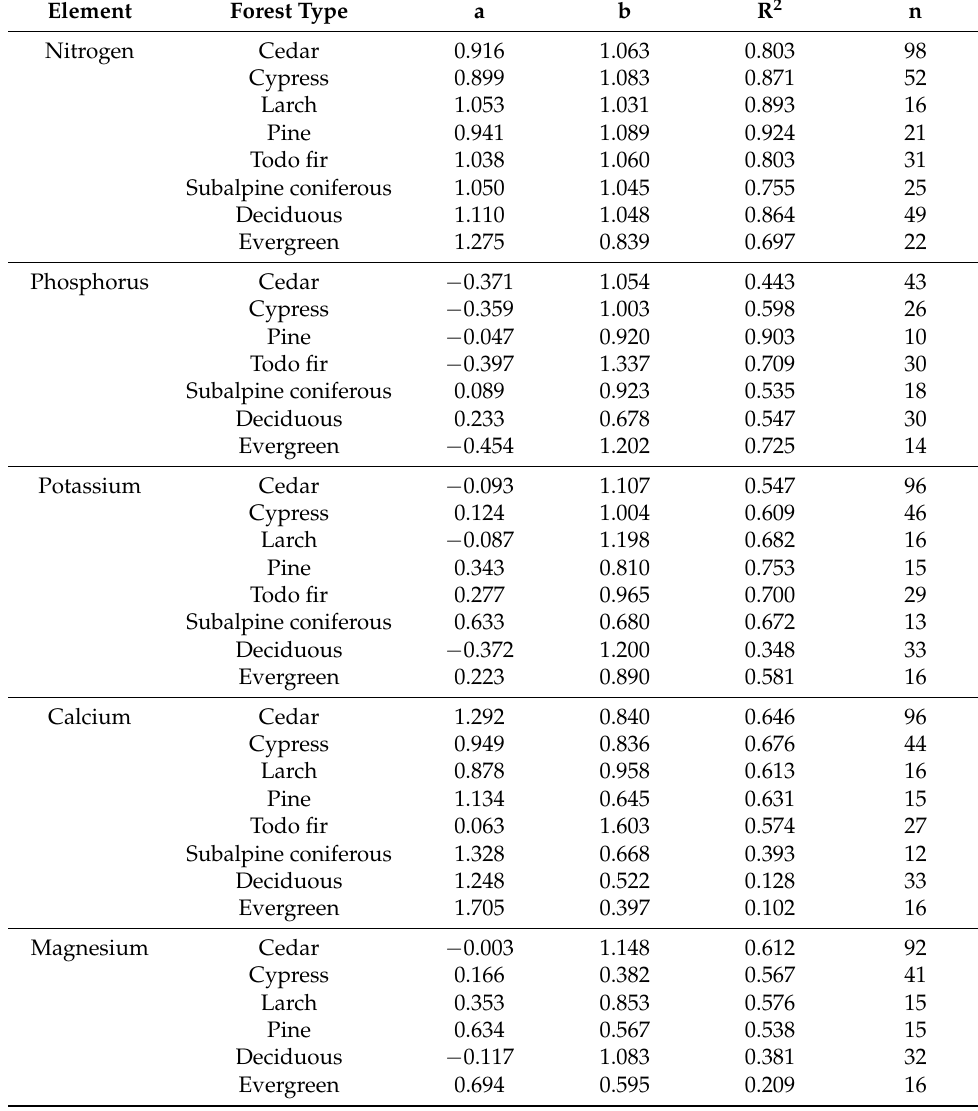
Table A1. Parameters and the coefficient of determination (R 2 ) for regression lines between el- ements/nutrients within and dry weight of the forest floor (FF) using the following